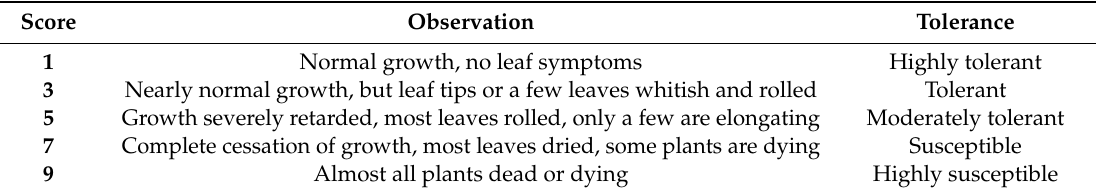
Table 2. Modified standard evaluation score (SES) of visual injury at the seedling